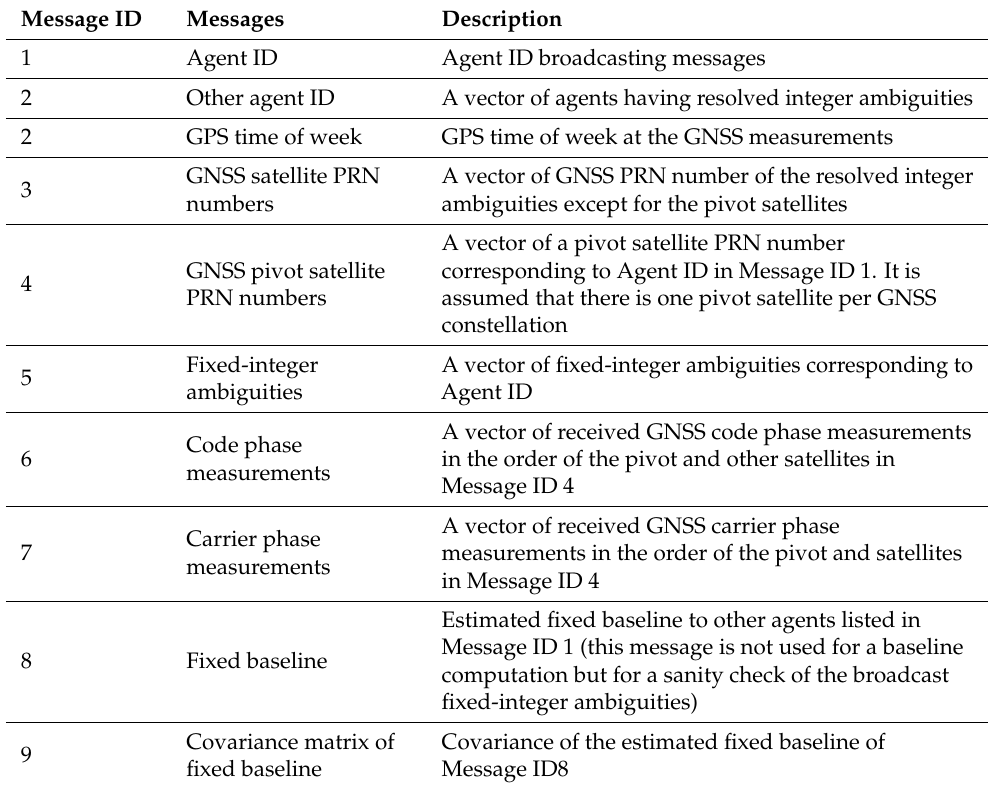
Table 1. Proposed message fields and descriptions for the ART